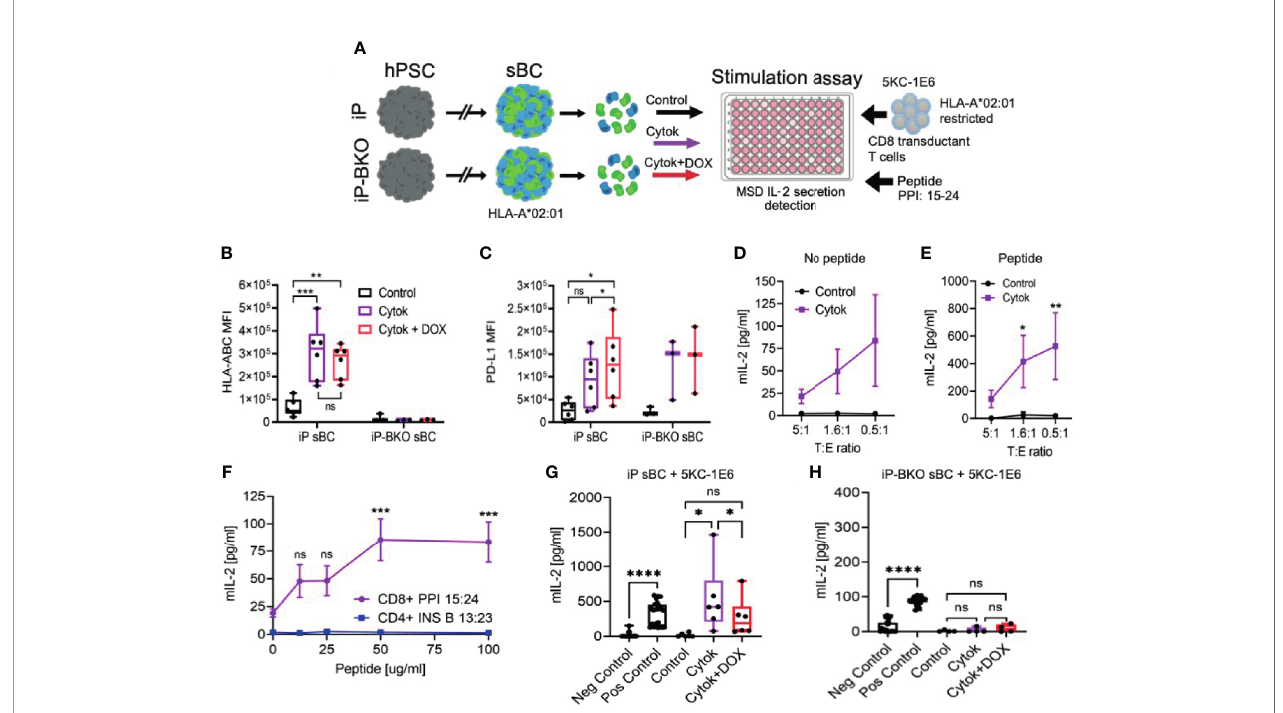
FIGURE 4 | sBC activate a preproinsulin speci fi c CD8 T cell receptor transductant in an HLA and PD-L1 dependent manner. (A) Schematic depicting the sBC and CD8 T cell receptor transductant (5KC-1E6) co-culture experimental assay set up. iP and iP-BKO cells were differentiated into sBC as clusters, followed by dissociation into single cells. sBC were treated with control (black), 2-day pro-in fl ammatory cytokines (purple) or with pro-in fl ammatory cytokines and DOX (red) for 48hr. sBC were then incubated with preproinsulin (PPI) 15-24 peptide for 4 hours. This was followed by 5KC-1E6 co-culture overnight with measurement of mIL-2 from the cell culture supernatants. (B, C) Flow cytometry quanti fi cation of surface HLA-ABC (B) or PD-L1 (C) expression on iP and iP-BKO sBC after treatments. Data is shown as MFI in box and whisker plots. Each dot represents a single differentiation experiment. Ordinary One-Way Anova was performed with Tukey ’ s multiple comparison test with *p ≤ 0.05, **p ≤ 0.01, ***p ≤ 0.001 and ns denoting no signi fi cant changes. (D, E) Stimulation assay of sBC treated with (purple) or without cytokines (black) followed by co-culture with 5KC-1E6 T cells at denoted target to effector rations (T:E). Note that sBC were cultured with (E) or without (D) exogenous PPI: 15-24 peptide. Data is presented as mean secreted mIL-2 concentration +/- SEM of 5 independent differentiation experiments. 2-way Anova with Sidak ’ s multiple comparison test was performed with *p ≤ 0.05, and **p ≤ 0.01. (F) Peptide titration experiment of different peptide-TCR combinations. sBC were treated with cytokines and incubated with different concentrations of PPI: 15-24 (purple line) or INS B 13:23 (blue line) peptides. sBC were co-culture with corresponding CD8 T cell receptor transductants. Data is presented as mean secreted mIL-2 concentration +/- SEM of 3 independent differentiation experiments. 2-way Anova with Sidak ’ s multiple comparison test was performed with ***p ≤ 0.001, and ns denoting no signi fi cant changes. (G, H) Stimulation assay of co-culture of 5KC-1E6 cells with iP (G) or iP-BKO (H) sBC after denoted treatments and incubated with exogenous PPI: 15-24. 5KC-1E6 alone or treated with anti-CD3 antibody served as negative and positive controls, respectively. Note the signi fi cant reduction in T cell stimulation upon PD-L1 expression (red) compared to only cytokine treatment (purple). Data is shown as box and whisker plots of secreted mIL-2. Each dot represents an independent stimulation assay with sBC from independent differentiation experiments. A paired t-test was performed with ns as no signi fi cant and *p ≤ 0.05, ****p ≤